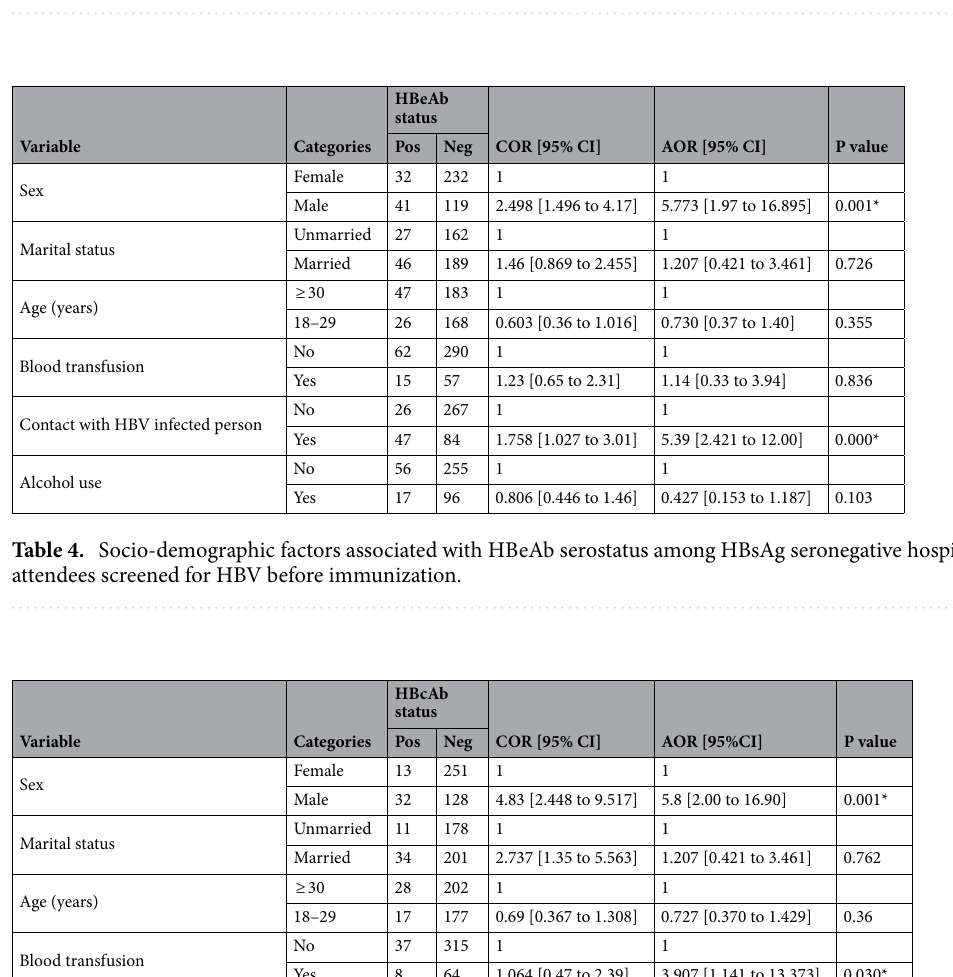
Table 3. Socio-demographic factors associated with HBsAb serostatus among HBsAg seronegative hospital attendees screened for HBV before immunization.